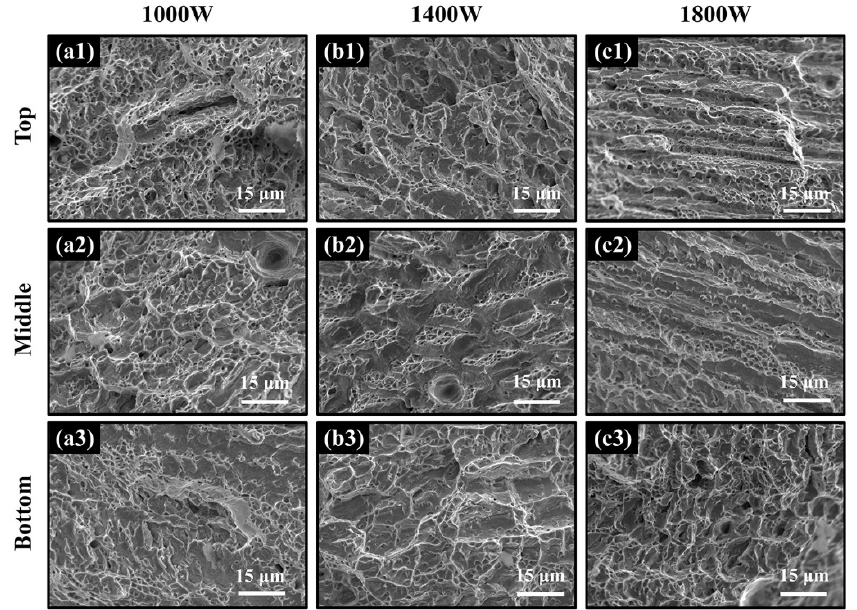
Figure 10. The fracture surfaces of the Al 0.5 FeCoCrNi HEA fabricated by LMD ( a1 – c3 ), where 1, 2, and 3 represent the top, middle, and bottom locations of the sample, respectively.